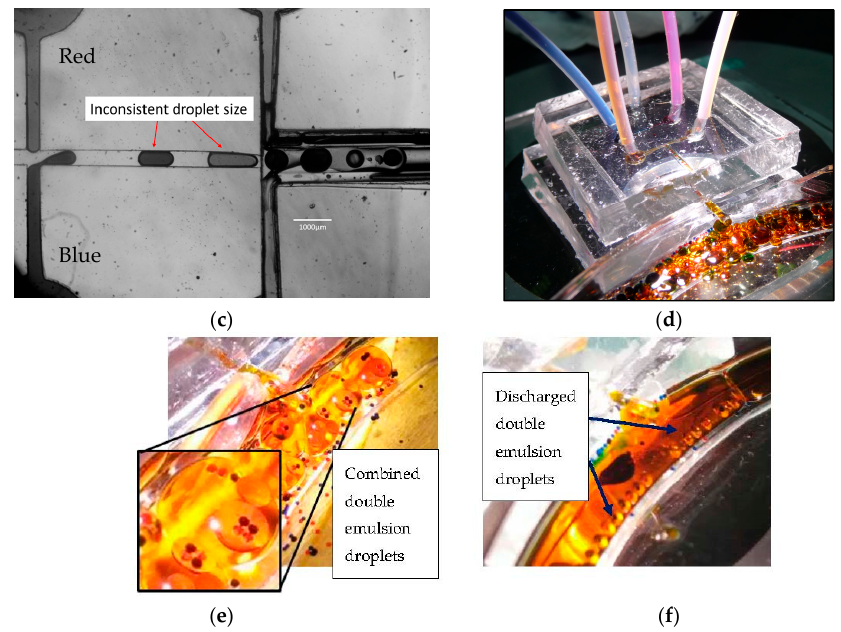
Figure 10. ( a ) Combination graph of droplet size versus flow ratio for Group A and Group B. Note